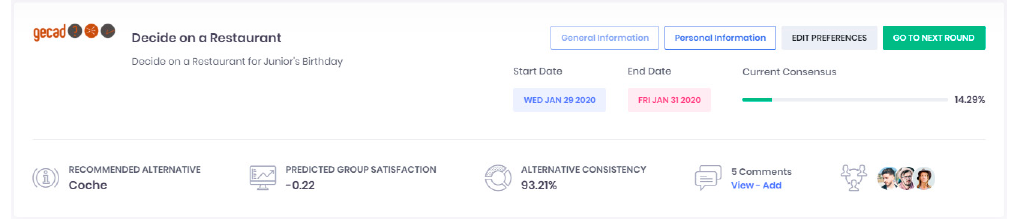
Figure 2. The top of the dashboard presented to each decision-maker.